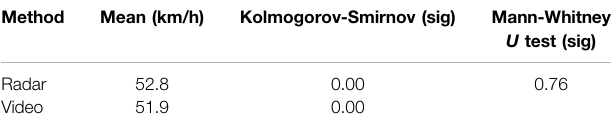
TABLE 6 | Mann-Whitney U test, results for all readings.